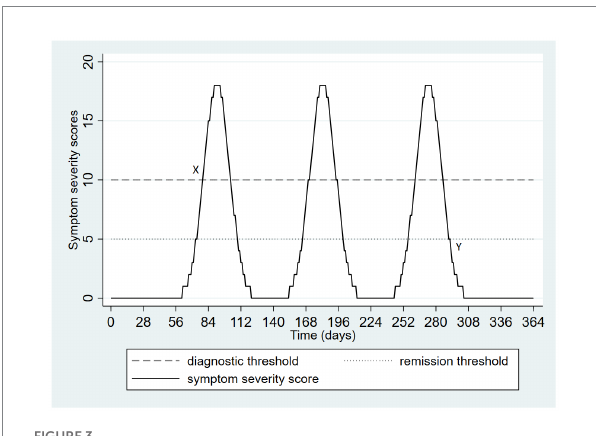
FIGURE 6 Hypothetical pattern of symptom severity over one year, depicting a loss of information due to categorization using thresholds: similar patterns are made to seem different and vice